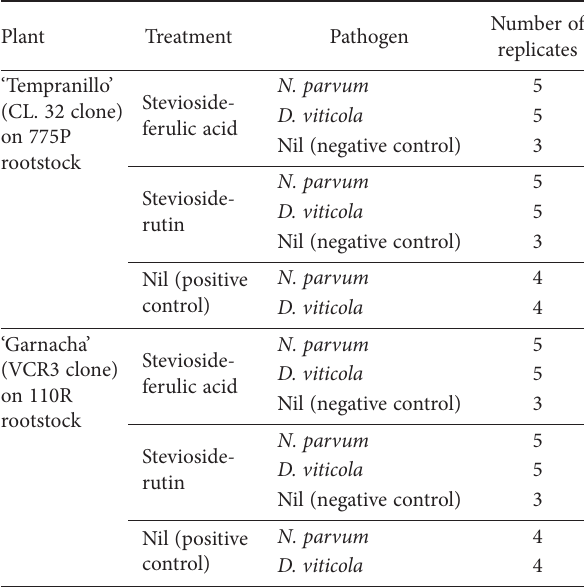
Table 1. Details of plant/treatment combinations for the greenhouse bioassay. Each grafted plant was inoculated at two sites below the grafting